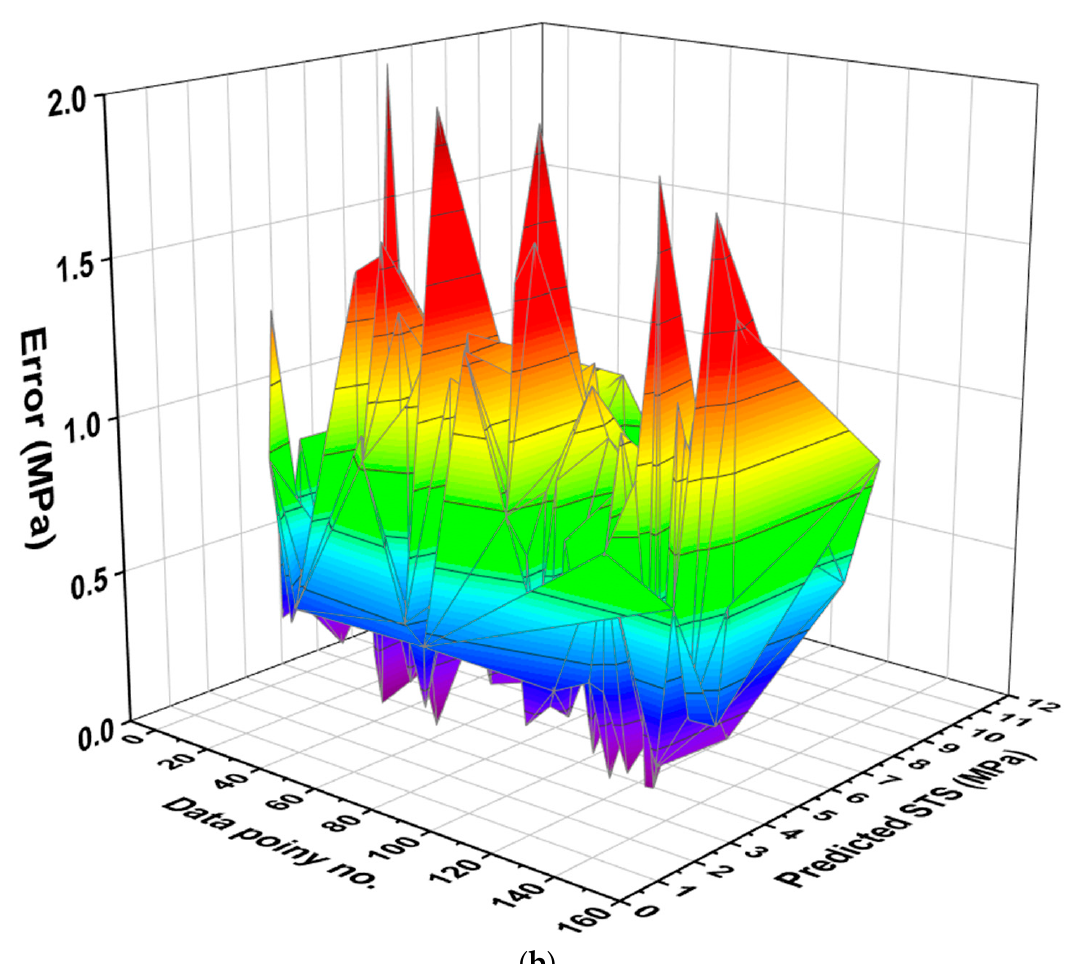
Figure 9. Regression model for STS: ( a ) correlation between actual and predicted results; ( b ) distribution of predicted and error values.